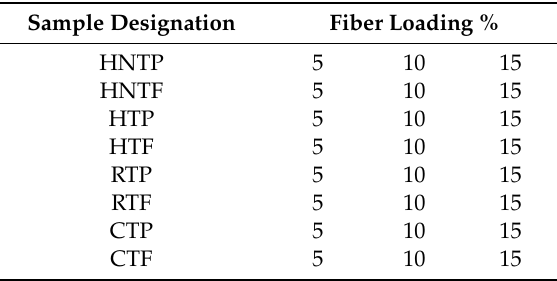
Table 2. Formulations of composite